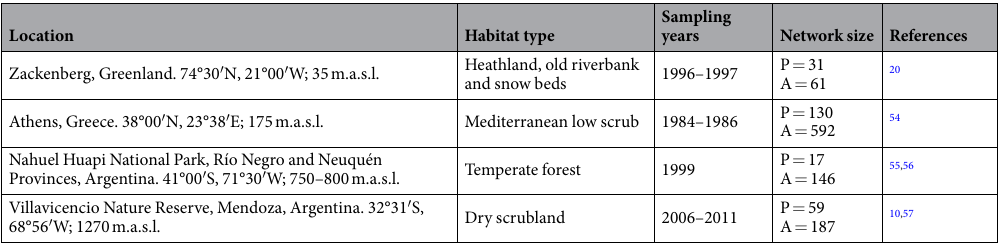
initiation, late phenophase termination and longer phenophases. In turn, pollinator persistence was especially affected when larval mortality increased for pollinators with low degree, earlier phenophase initiation and late phenophase ending. Increased plant mortality ( μ P ), especially on plants with earlier and longer phenophases, led to decreased plant and pollinator persistence. Under increased seed mortality ( μ S ), the impact on both plant and pollinator persistence was stronger when the pressure was exerted on plants with earlier phenophase initi- ation, later phenophase termination and longer phenophases. Decreased visitation rate ( τ ) and adult pollinator mortality ( μ A ) had only weak effects on species persistence compared to other pressures. However, the observed effects of decreased visitation rate of pollinators with low degree or short phenophases were strong compared to decreasing visitation rates in species at random. The conducted sensitivity analysis (see Supplementary Information S5) indicate that our results are robust to the choice of parameter values, as they remained similar with different levels of random variation in model parameter values. A general visualization of NMDS results can be seen in Supplementary Information S4. Mantel statistic was positive and significant ( r = 0.4277; P < 0.01), indicating that results are more similar between networks of the